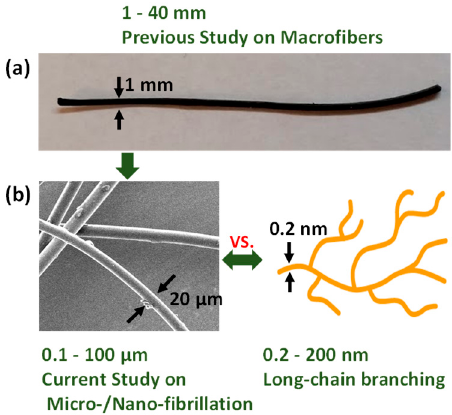
Figure 1. Comparison among fibers used in the previous and current studies, along with long-chain branching. ( a ) The previous study [12] was conducted using macroscale shrinking fibers, which showed the feasibility of the improvement of strain hardening as well as the foamability. ( b ) As a next phase, the current study has been conducted with microscale fibers.